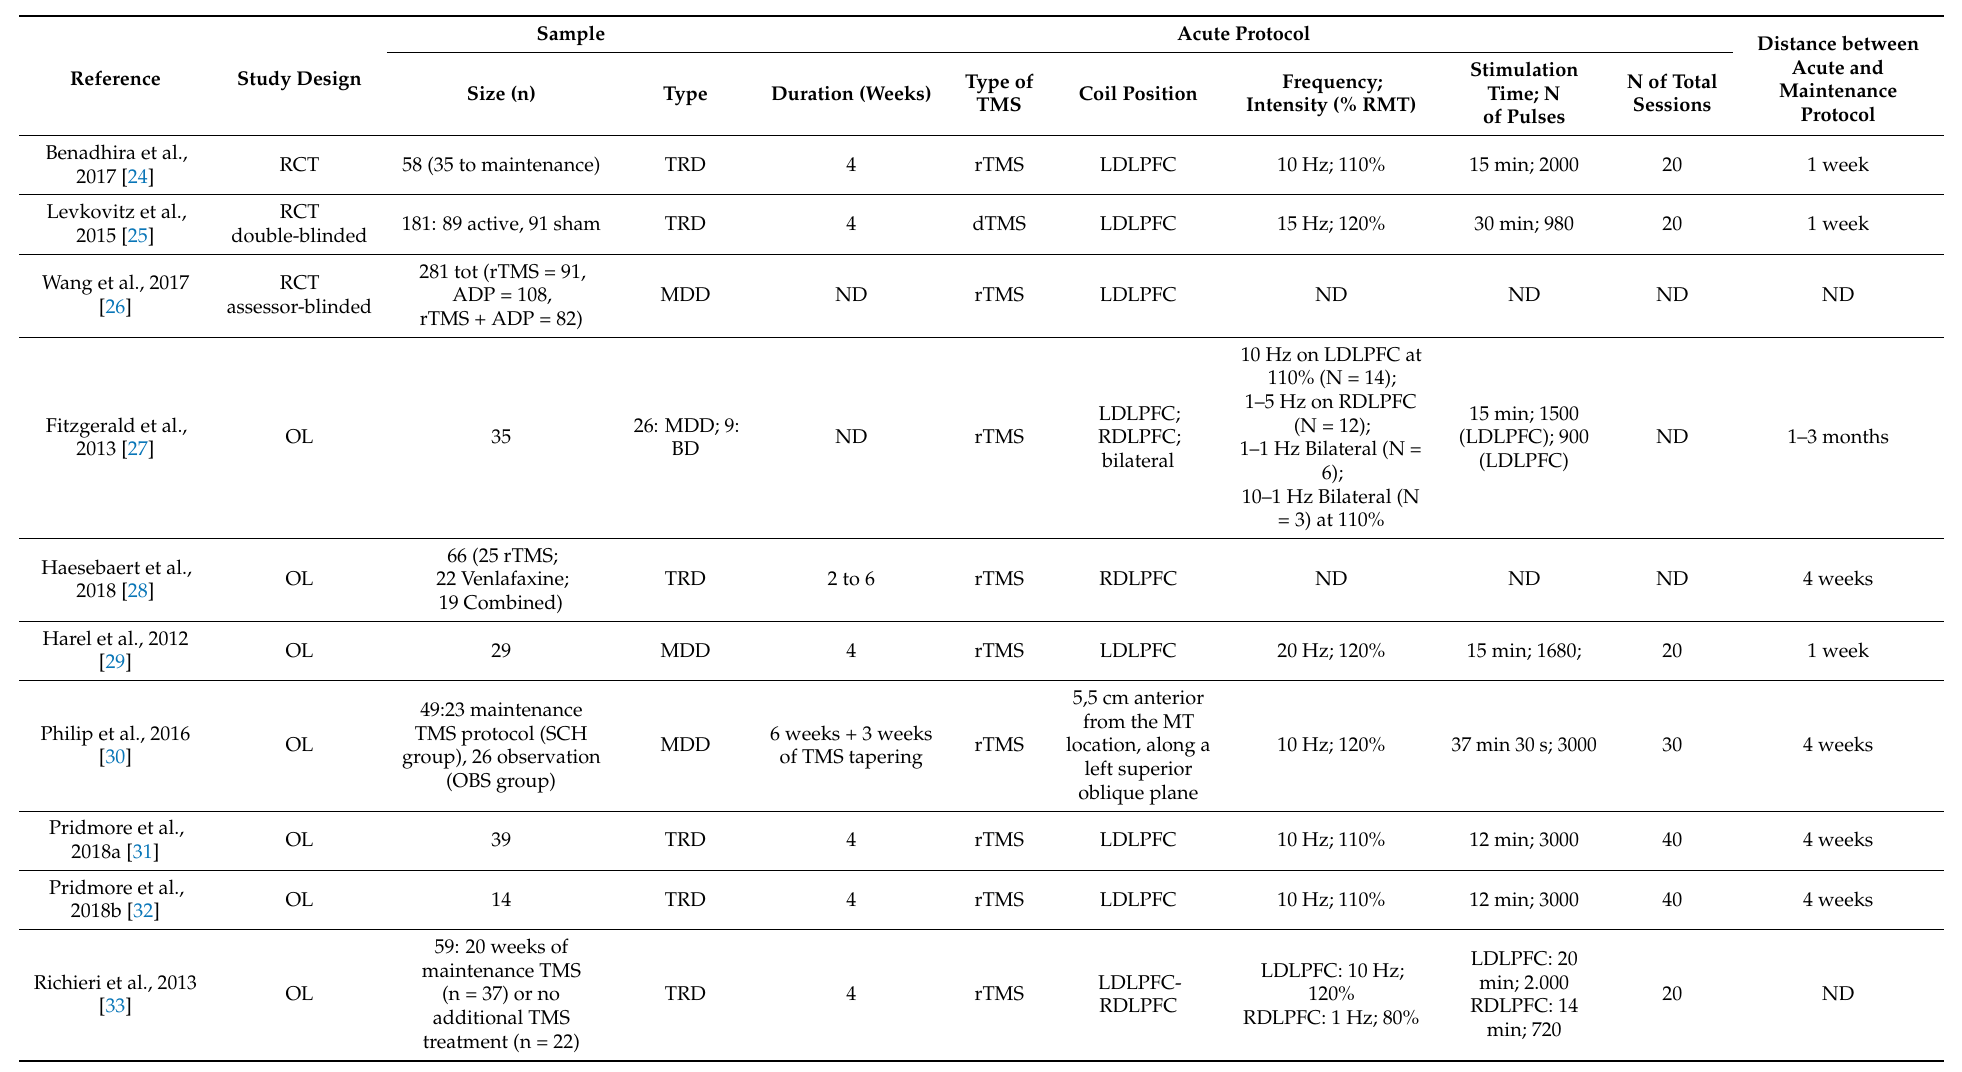
Table 1. Acute protocols sorted by study design and alphabetical